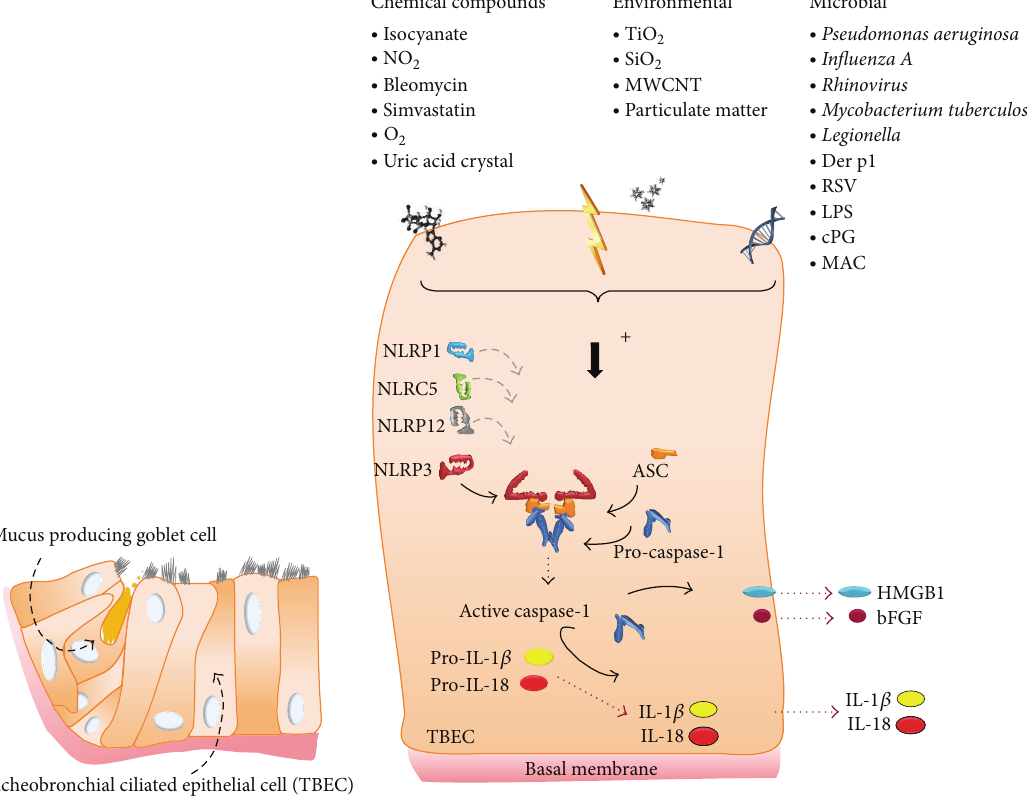
Figure 4: Schematic representation of pseudostratified columnar epithelium of the lung indicating a variety of environmental and microbial molecules that is able to activate the inflammasome with a subsequent release of cytokines, alarmins, and growth